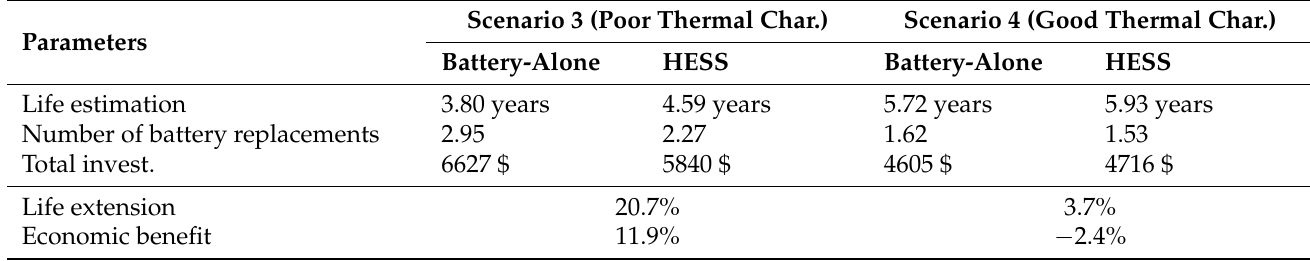
Table 8. Results of different scenarios of thermal